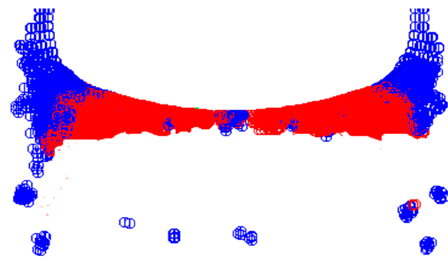
Figure 15. Plastic zone of optimization scheme.